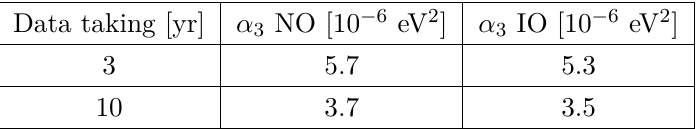
DUNE, JUNO, MOMENT, ESSnuSB, and INO. Note that the limit coming from